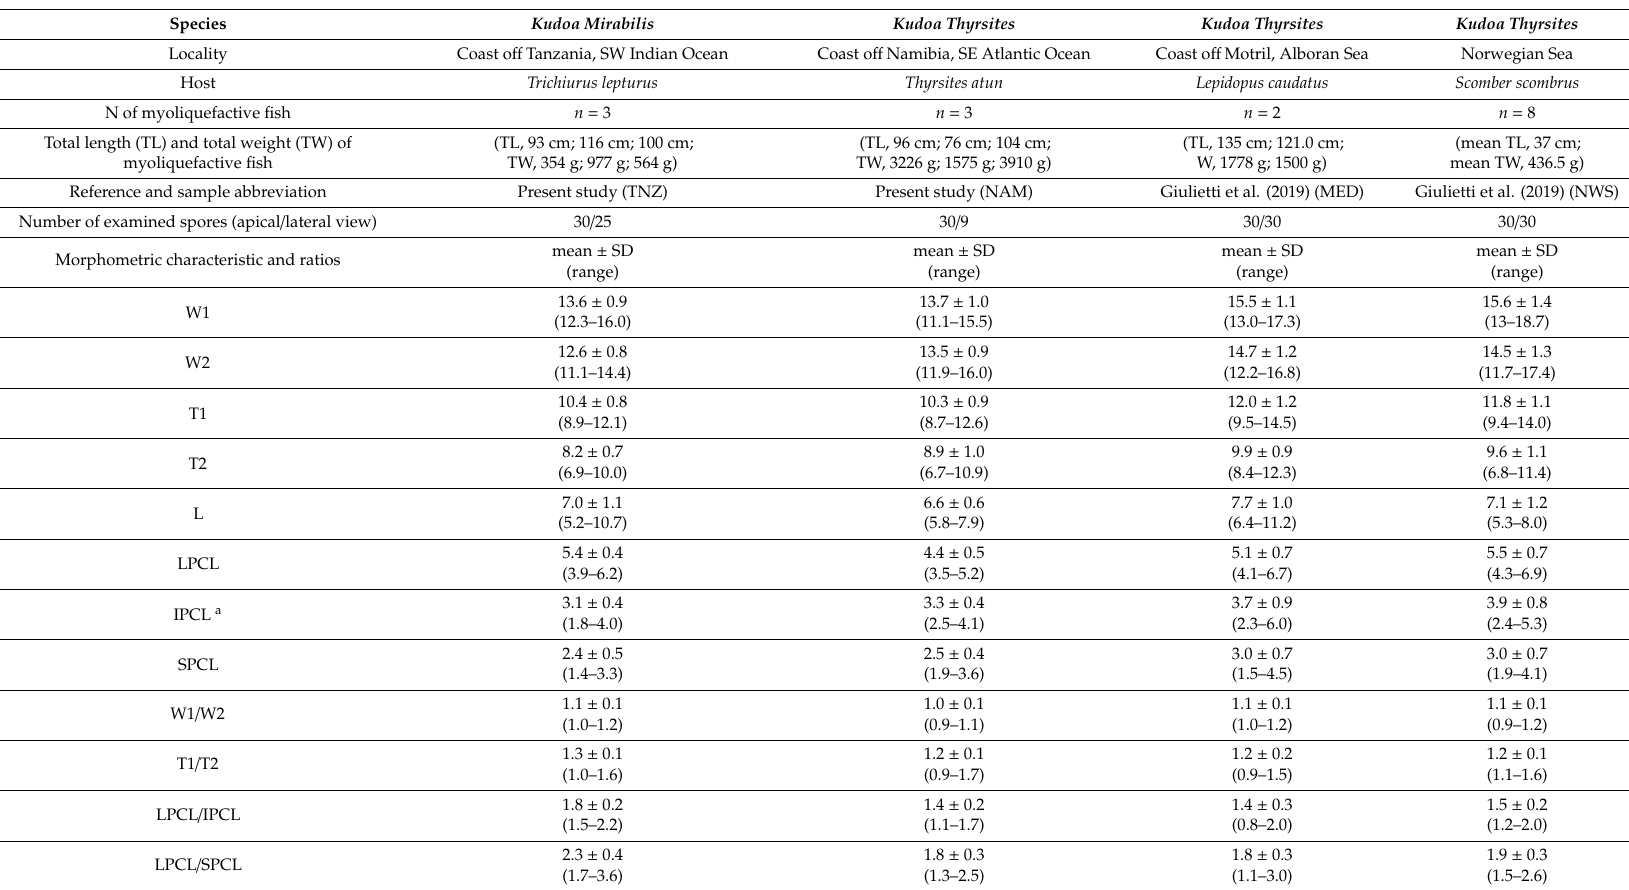
Table 1. Spore morphometry of Kudoa mirabilis infecting Trichiurus lepturus from the South-West Indian Ocean (TNZ) and K. thyrsites isolates infecting Thyrsites atun o ff the coast of Namibia (NAM), Lepidopus caudatus from the Mediterranean Sea (MED) and Scomber scombrus from Norwegian Sea (NWS). Measurements are given in µ m as mean, standard deviation, and range in parenthesis. W1, Width1; W2, Width2; T1, Thickness1; T2, Thickness2; L, Length; LPCL, Length of large polar capsule; IPCL, Length of intermediate polar capsule; and SPCL, Length of small polar